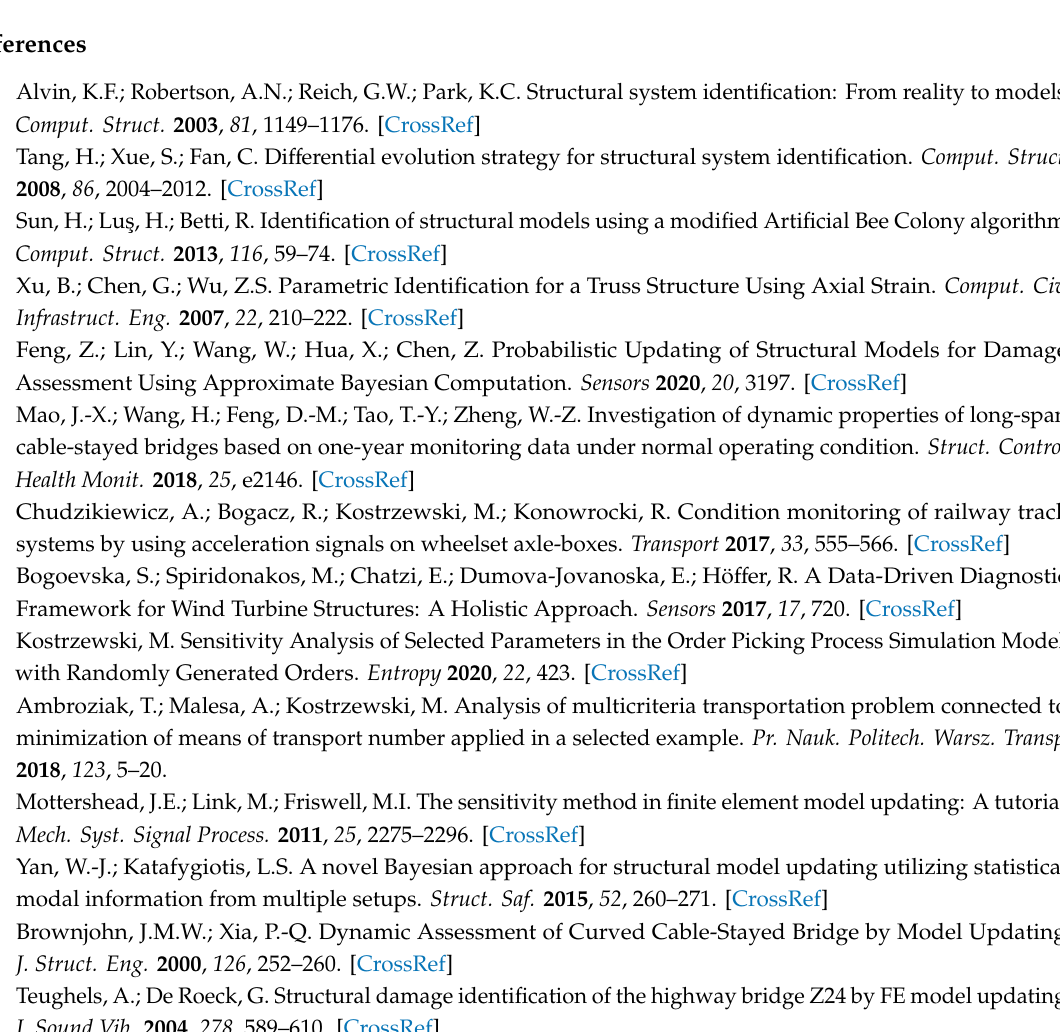
AlgorithmA8. Complete pseudocode [ x best , f ( x best )] = EM _ m